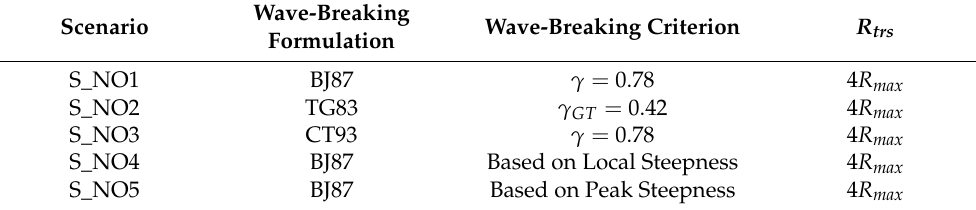
Table 2. Designed numerical experiments in the present